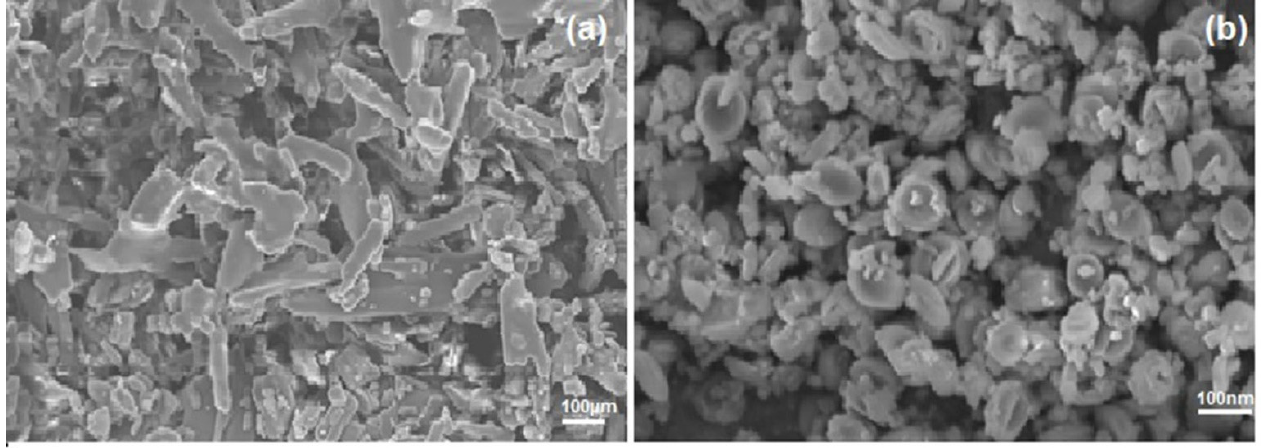
Figure 5. SEM photograph of ( a ) CRL-MC, and ( b ) CRL-NCs.